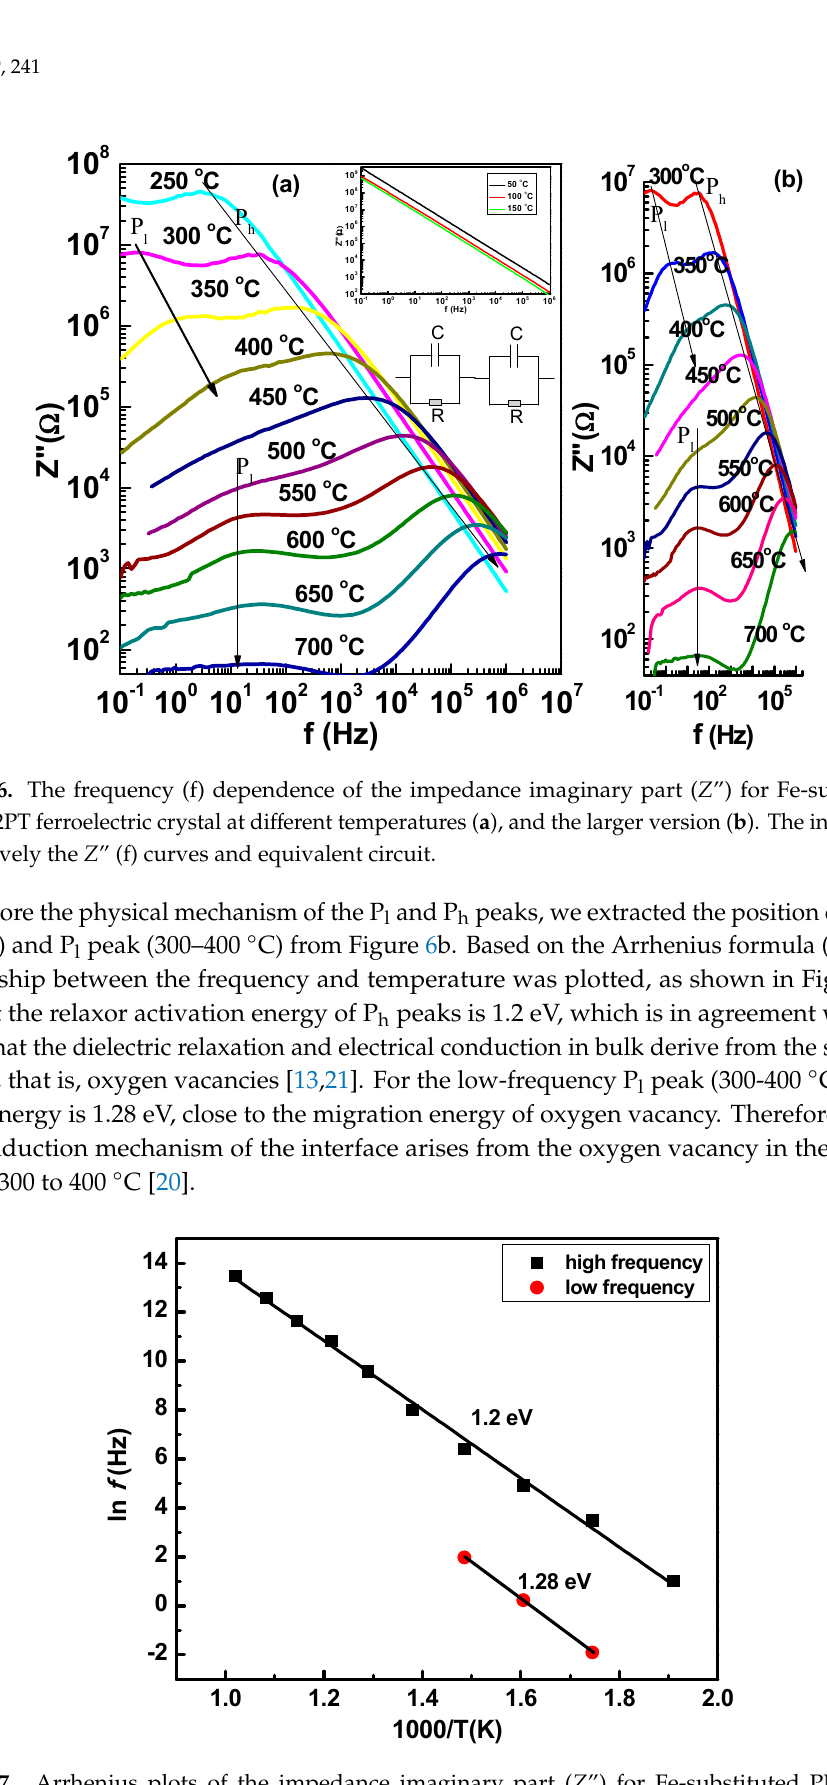
Figure 7. Arrhenius plots of the impedance imaginary part ( Z ″ ) for Fe-substituted PMN-32PT ferroelectric crystal.